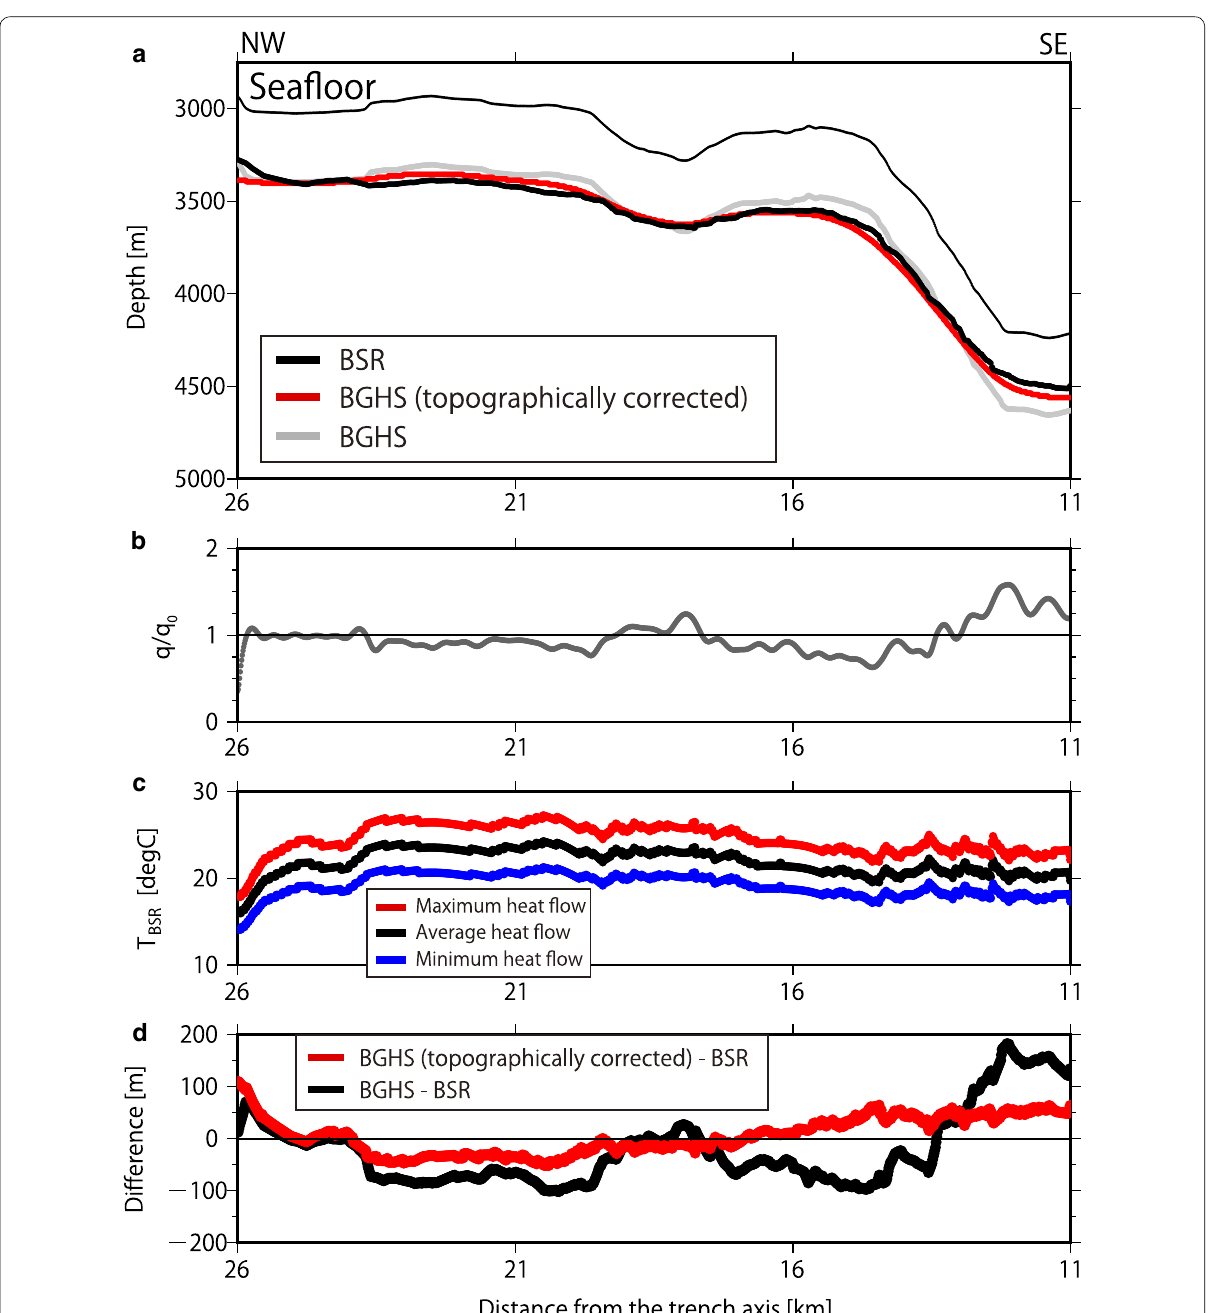
Fig. 9 BSR and BGHS in the convex-upward and convex-downward seafloor regions southwest of the Kii Peninsula. a Bathymetry with the depths of the observed BSR and the calculated topographically corrected BGHS (2-D) and uncorrected BGHS (1-D). b Plot of q / q 0 ratio, where q 0 is the heat flow originating from the deep-seated heat flux, and q is the heat flow estimated at the seafloor from the deep-seated heat flux. A ratio less than 1 indicates that the shallow subseafloor is subject to defocusing induced by the topography, and a ratio larger than 1 indicates that the shallow subseafloor is subject to focusing induced by the topography. c Error evaluation of the thermal modeling by comparison with the temperature of the BSR ( T BSR ) using maximum (red line), average (black line), and minimum (blue line) heat flow values. Temperature variations in the BSR fall within 3 °C. d Difference in depths between the observed BSR and calculated BGHS values with and without considering the topographic effect. The dif- ± ference between the BSR and the two-dimensional BGHS values considering the topographic effect is smaller than that between the BSR and the one-dimensional BGHS without considering the